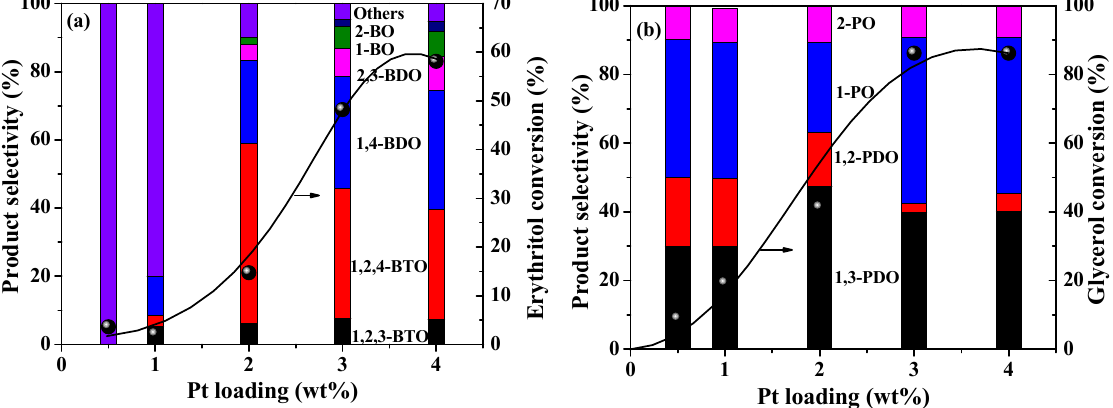
Figure 5. Influence of Pt loading on the HDO of ( a ) erythritol and ( b ) glycerol over xPt/1W/SBA-15 catalysts. Reaction conditions for ( a ): erythritol = 0.375 g, water = 12.125 g, catalyst = 0.3125 g, reaction temperature = 190 ◦ C, H 2 pressure = 50 bar, reaction time = 12 h, reactor volume = 50 mL. Conditions for ( b ): glycerol = 0.75 g, water = 24.25 g, catalyst = 0.625 g, reaction temperature = 190 ◦ C, H 2 pressure = 50 bar, reaction time = 12 h, reactor volume = 100 mL, stirring speed = 600